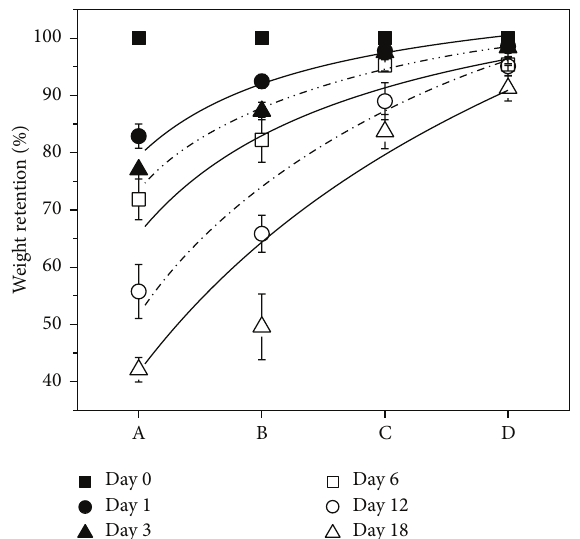
Figure 5: Weight change of the four groups of porous silk fibroin scaffolds during enzymatic